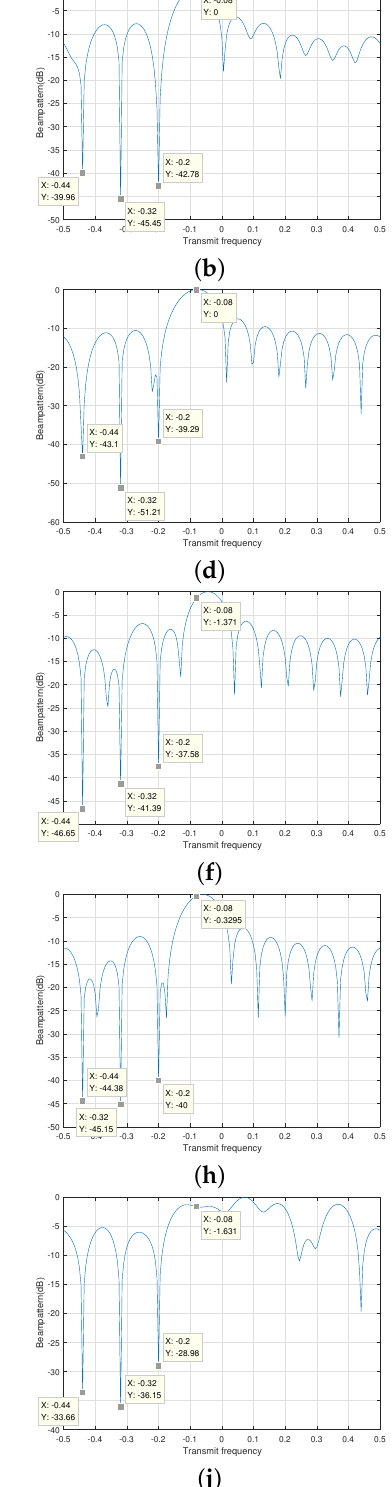
Figure 3. Beam-patterns of different methods in transmit-–receive domain and cross section at f r = 0 (SNR = − 30 dB). ( a , b ) Optimal, ( c , d ) proposed method (with SV estimation process), ( e , f ) LSMI- MVDR, ( g , h ) proposed method (without SV estimation process), ( i , j ) Eigenspace